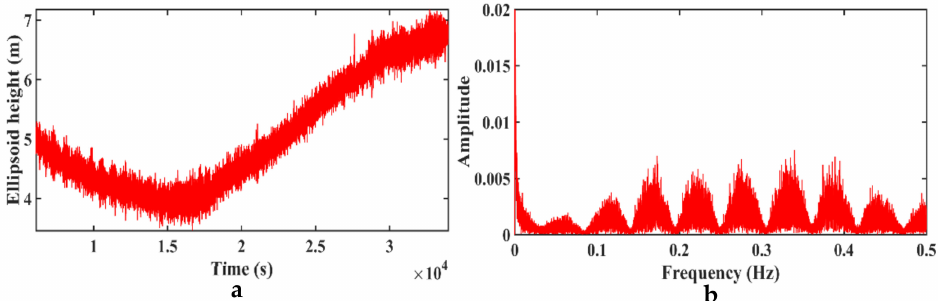
Figure 8. ( a ) The sea surface geodetic height sequence; ( b ) Spectrogram of the sea surface geodetic height sequence.